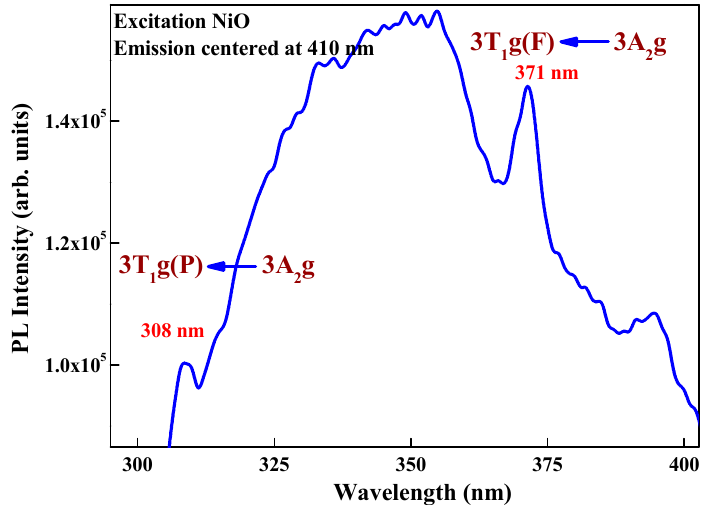
Figure 8. Excitation spectrum of NiO emission wavelength monitored at 410 nm.